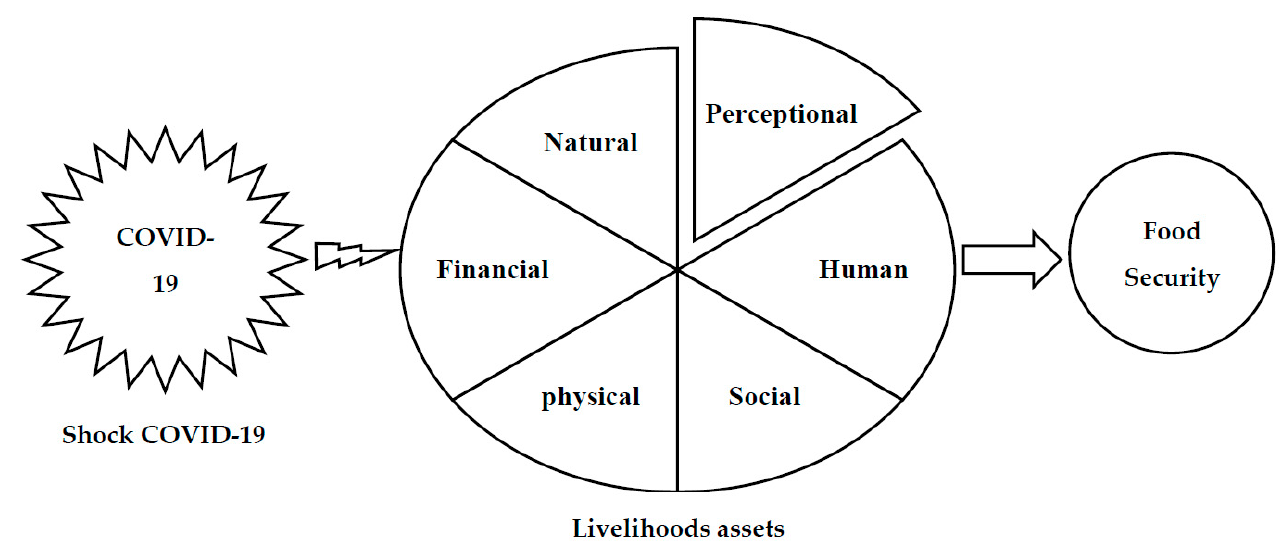
Figure 1. Research framework.